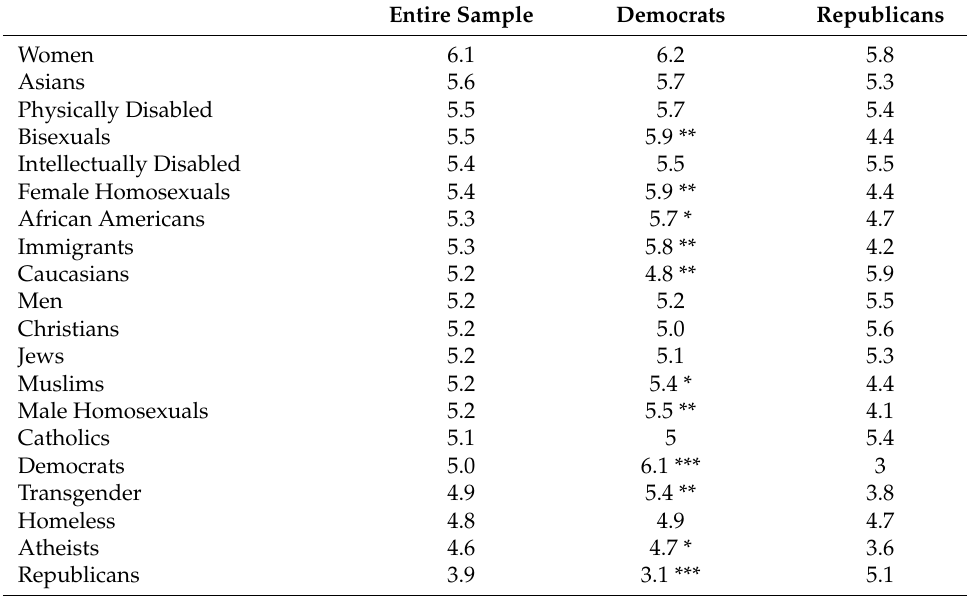
Table 4. Mean Ratings of Liking for 20 Social